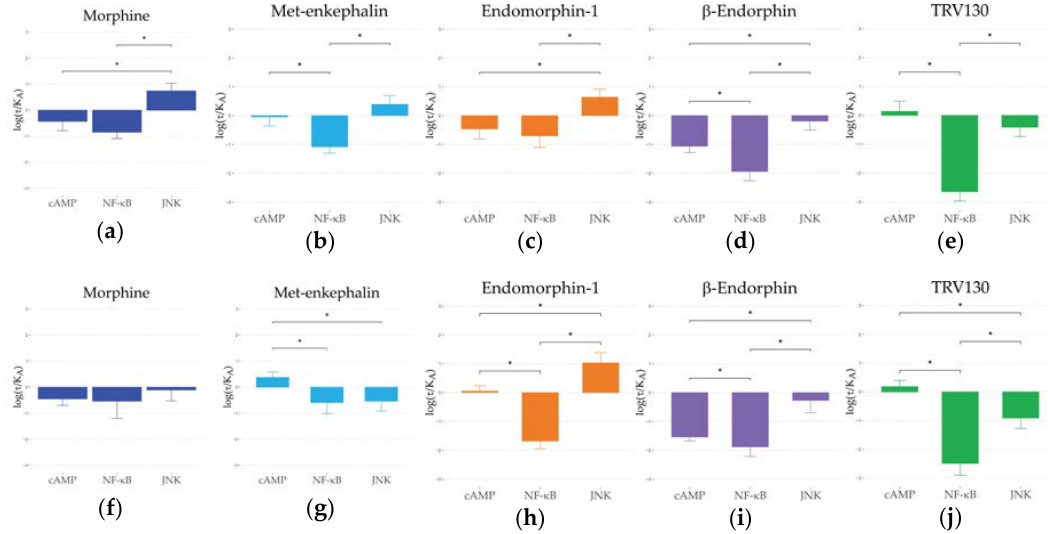
Figure 3. The ∆ log( τ ) values from three pathways for all ligands are shown for human ( a – e ) and rhesus macaque ( f – j ) MORs. * indicates p < 0.05 between signaling pathways.